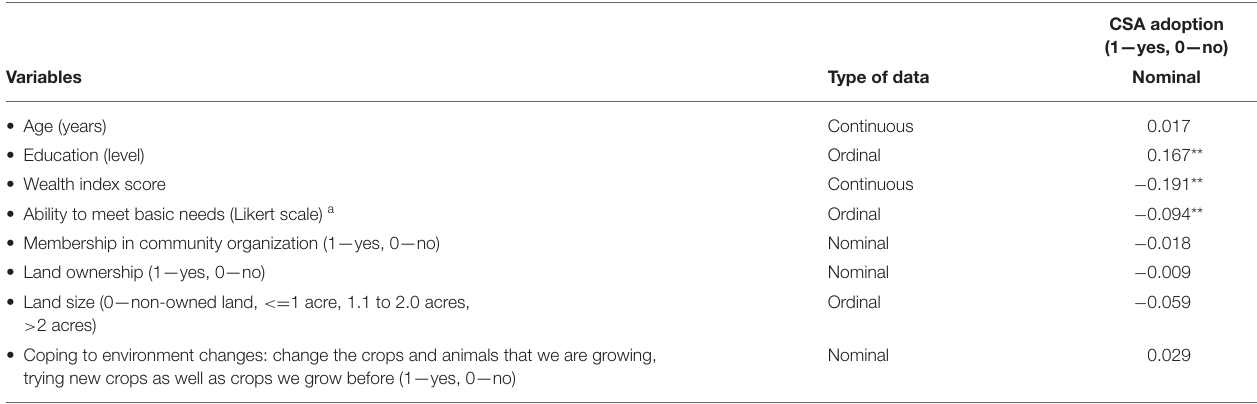
TABLE 7 | Correlation coefficients between different variables with CSA